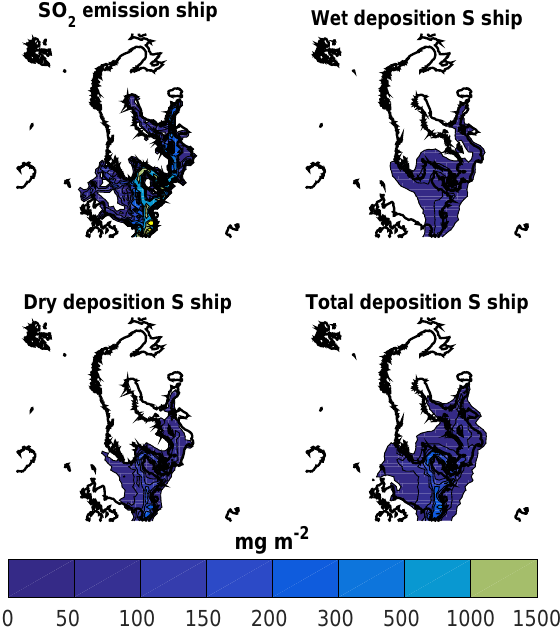
Figure 3. Total emissions of SO x and deposition of OXS from in- ternational shipping in the Baltic Sea and North Sea in 2011.